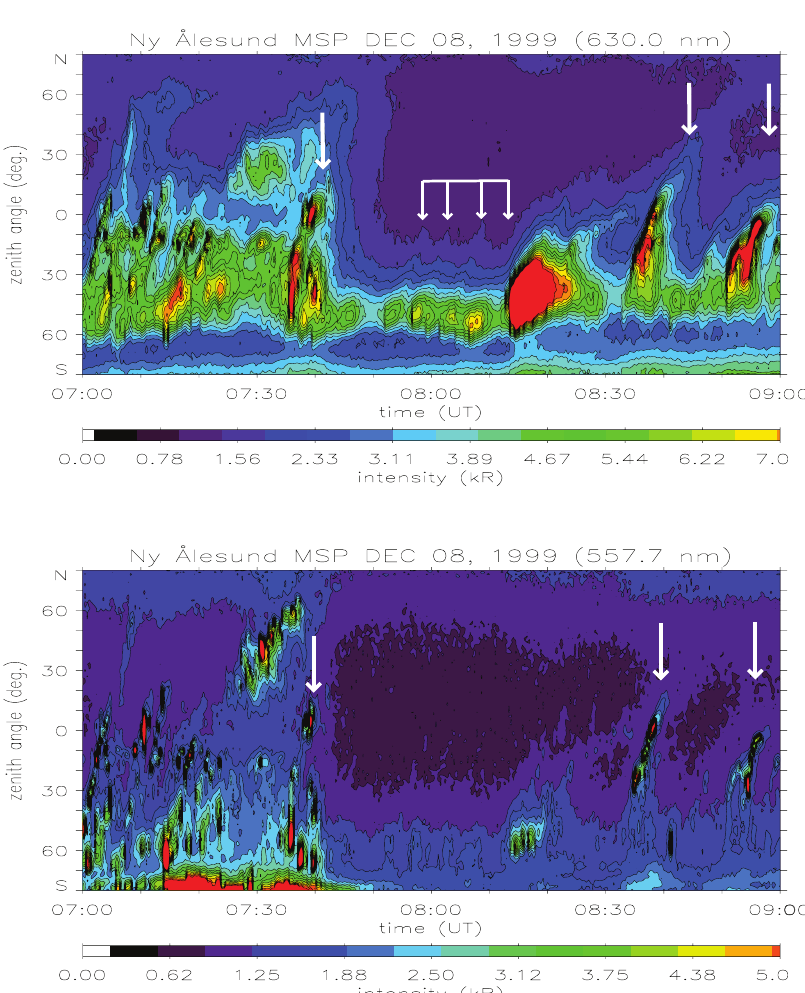
Fig. 10. MSP observations for the interval 07:00–09:00 UT on 8 December 1999. Upper and bottom panels show the red and green line emissions at 630.0 and 557.7nm, respectively. Same format as in Fig. 2. The auroral phenomena under discussion are marked by white